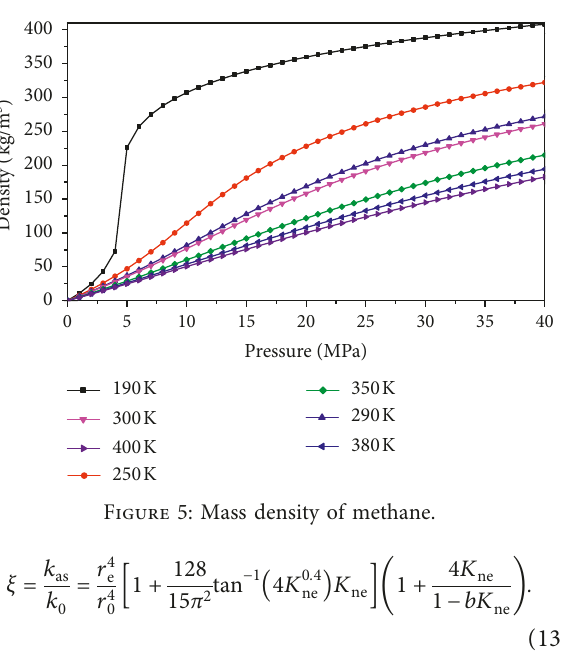
Figure 4: Deviation factor of methane.